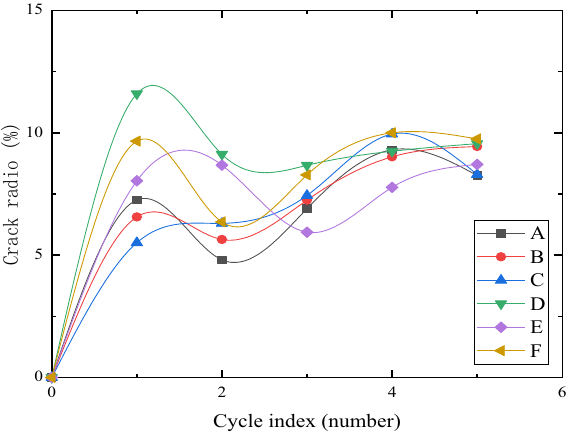
Figure 11. Development of crack ratio in five dry–wet cycles ( a – e